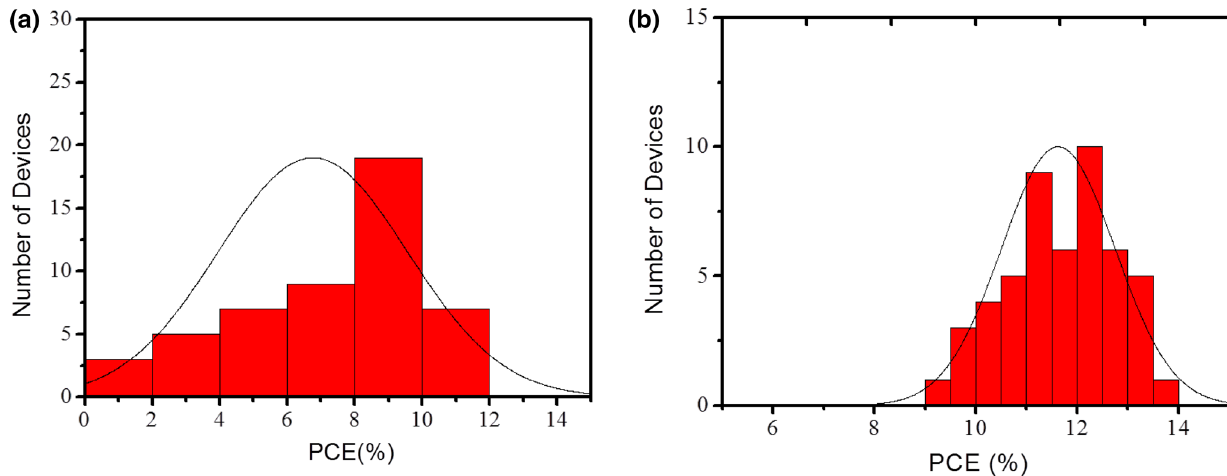
Fig. 11 PCE histogram of 50 devices derived from a annealing immediately after spin coating and b aging after spin coating before